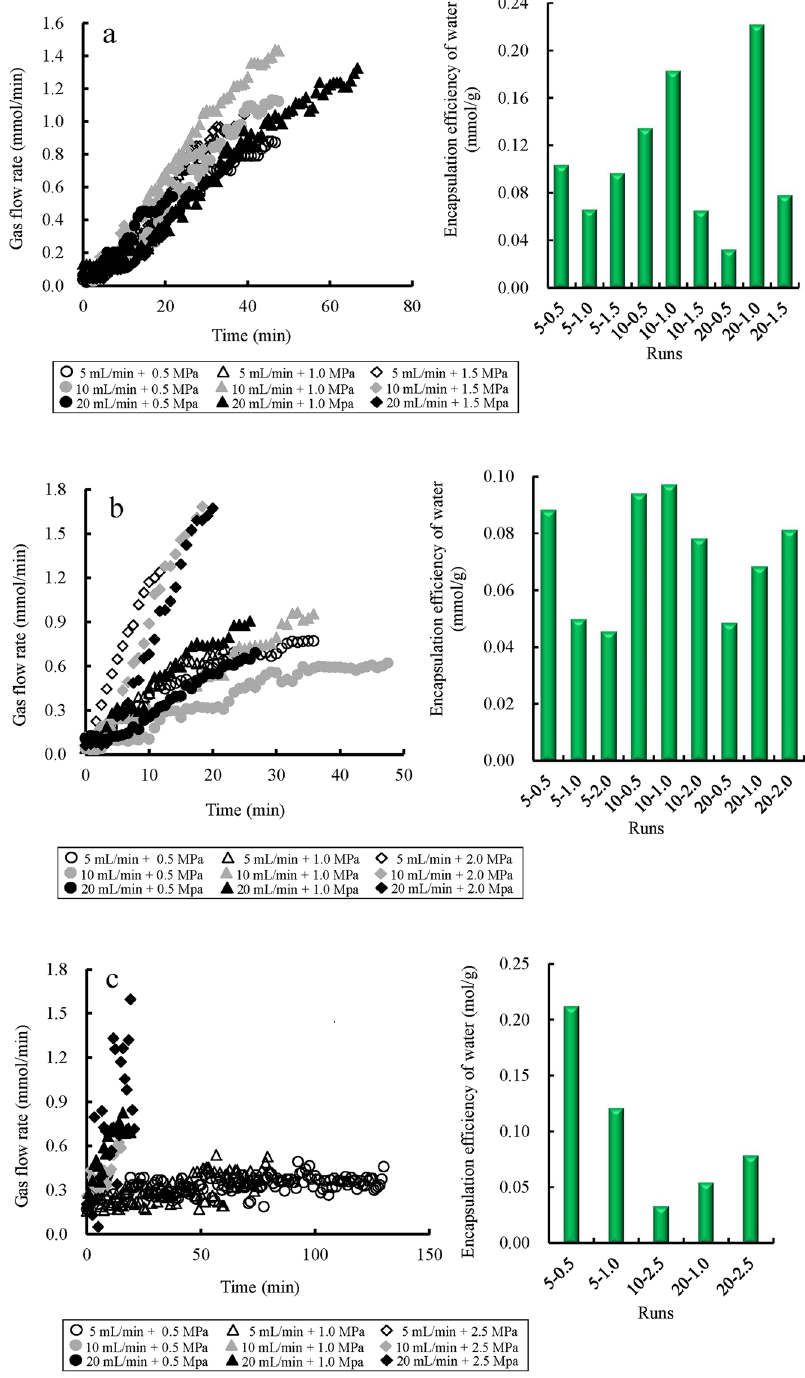
Figure 3. Changes in gas flow rates against time, and final ratios between the amounts of gas contained in the hydrate versus the weight of water during stage I at different predesigned temperatures: ( a ) 1.45, ( b ) 6.49, and ( c ) 12.91